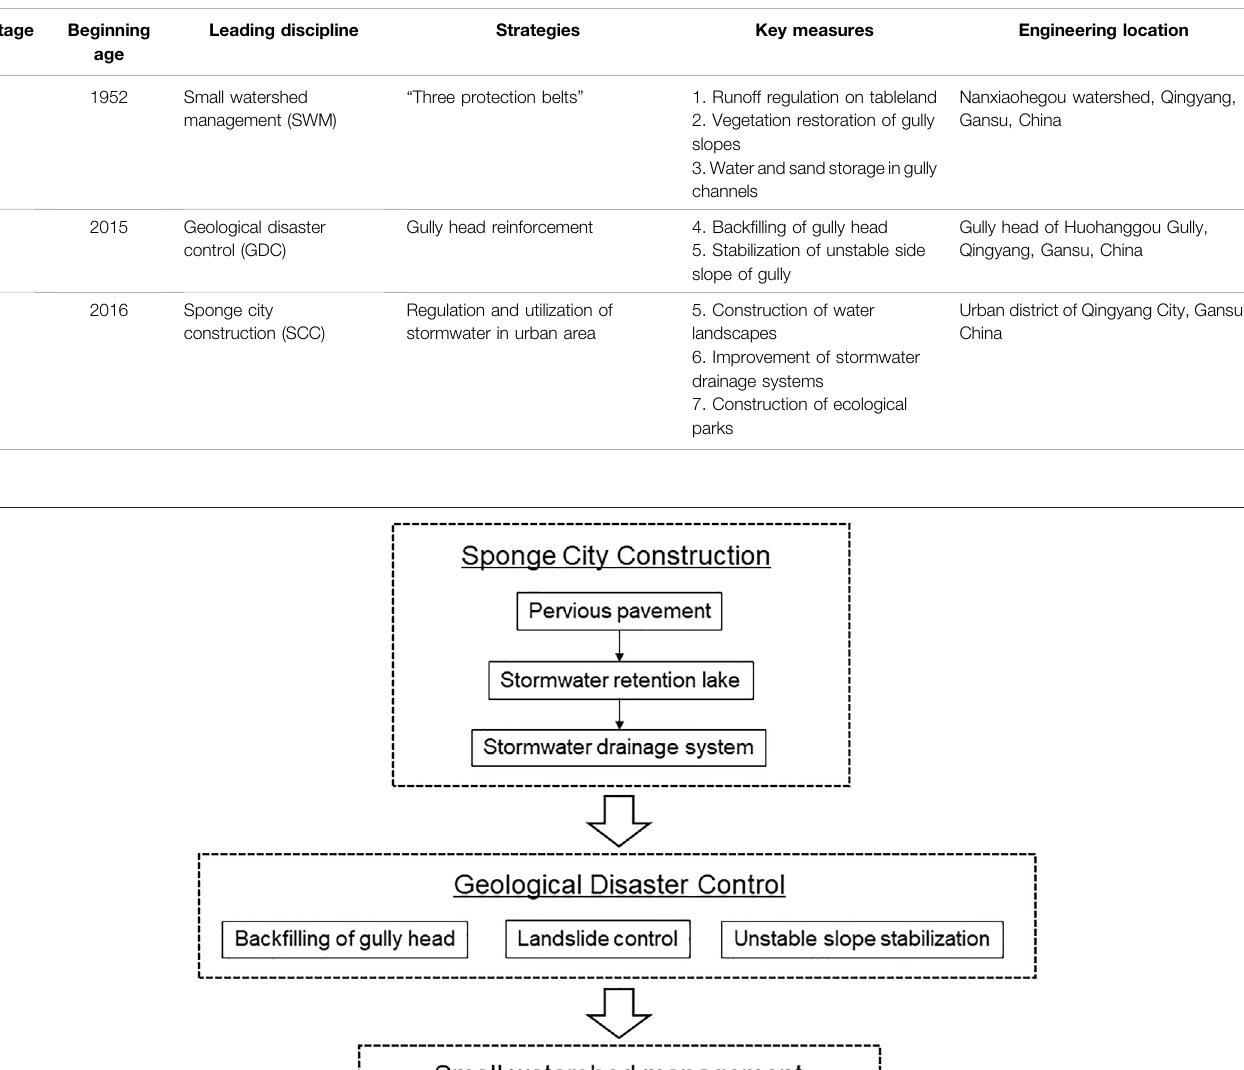
TABLE 3 | Strategies and measurements of the GSHP project.